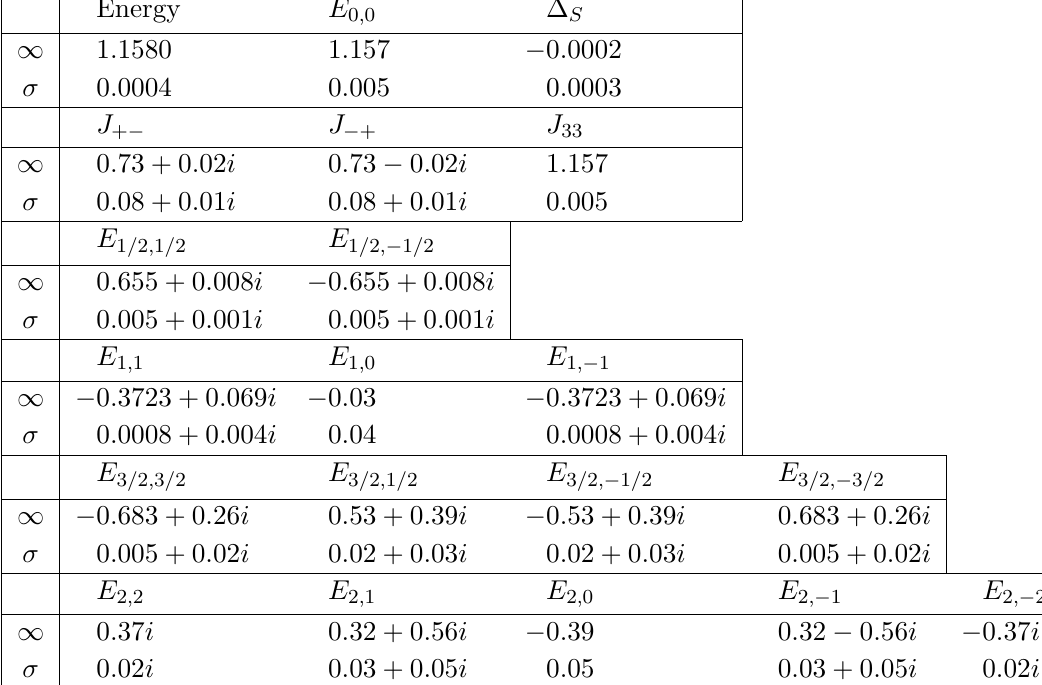
Table 24 . Extrapolations of gauge invariants of exotic solution number 4669 in the k = 8 model with J = 3 boundary conditions. Due to large number of invariants, we decided to show invariants 2 only up to j = 2 to fit a